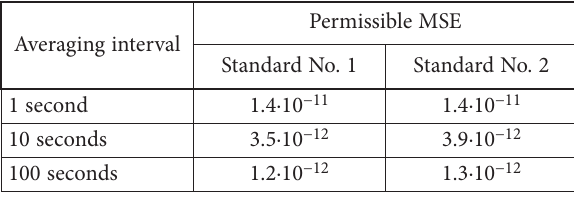
Table 1. Technical parameters of rubidium frequency